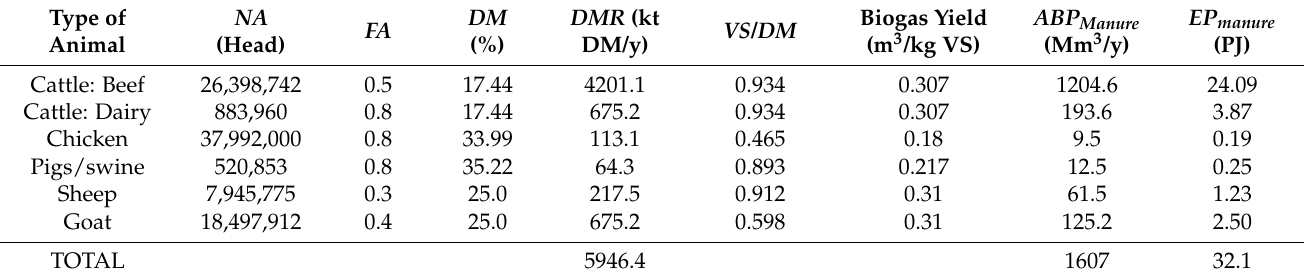
Table 9. The energy potential (EP) available from the livestock residues in